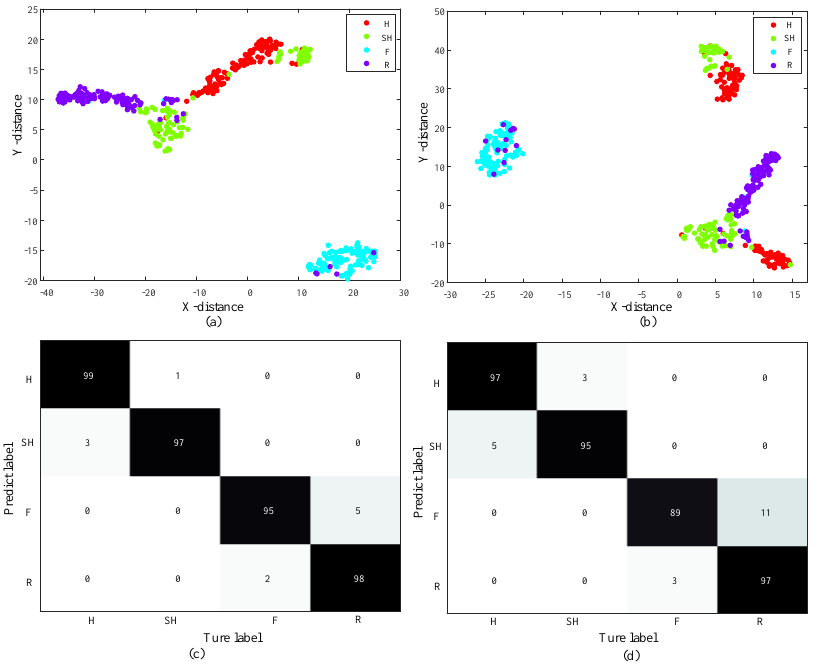
Figure 10. Visualization of classification results and error matrix: ( a ) visualization of AF-CDN; ( b ) error matrix of AF-CDN; ( c ) 1D-CNN visualization; ( d ) 1D-CNN error matrix.